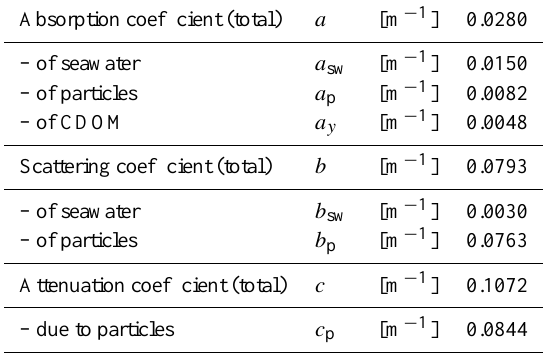
Table 2. Inherent optical properties of the considered water body at 490nm wavelength and with 0.1mgm − 3 chlorophyll a concentra- tion (Morel et al., 2007; Morel,